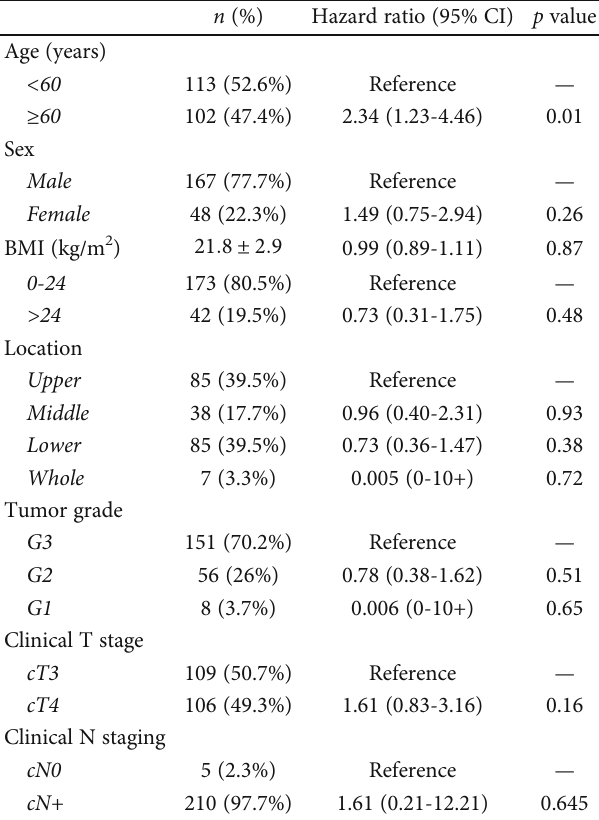
Table 1: Patient characteristics, hazard ratios, and p values from univariable survival analysis ( n = 215